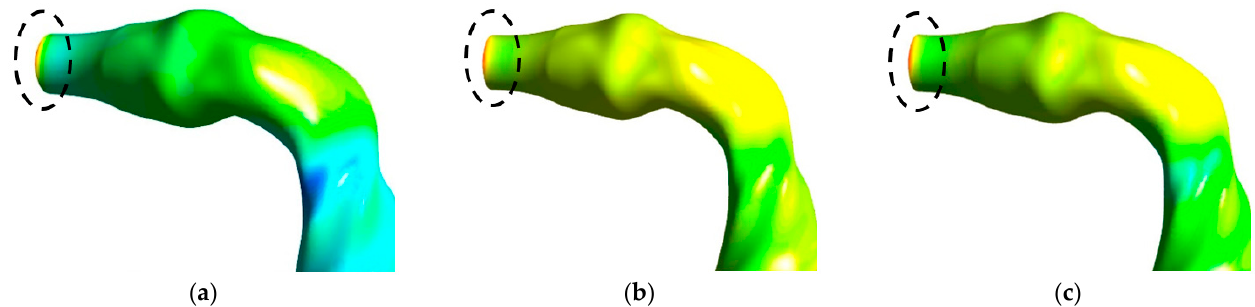
Figure 8. Pressure variation at the mouth-throat area: ( a ) 50-year-old lung, ( b ) 60-year-old lung, and ( c ) 70-year-old lung.